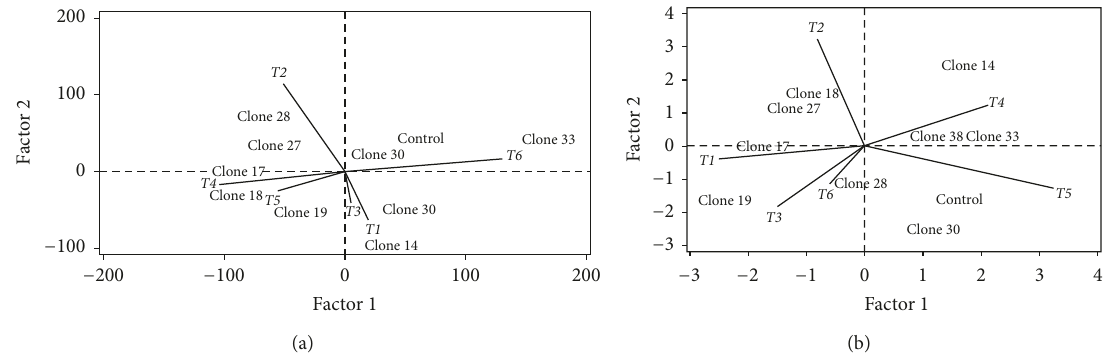
Figure 3: AMMI biplot for (a) yield and (b) pyruvic acid content showing genotypes and trials. Any two trials or genotypes are highly correlated if they are located at nearly the same angle from the center of the plot; it will be negatively correlated if opposing and nearly uncorrelated if the angle between them is close to 90 degrees.